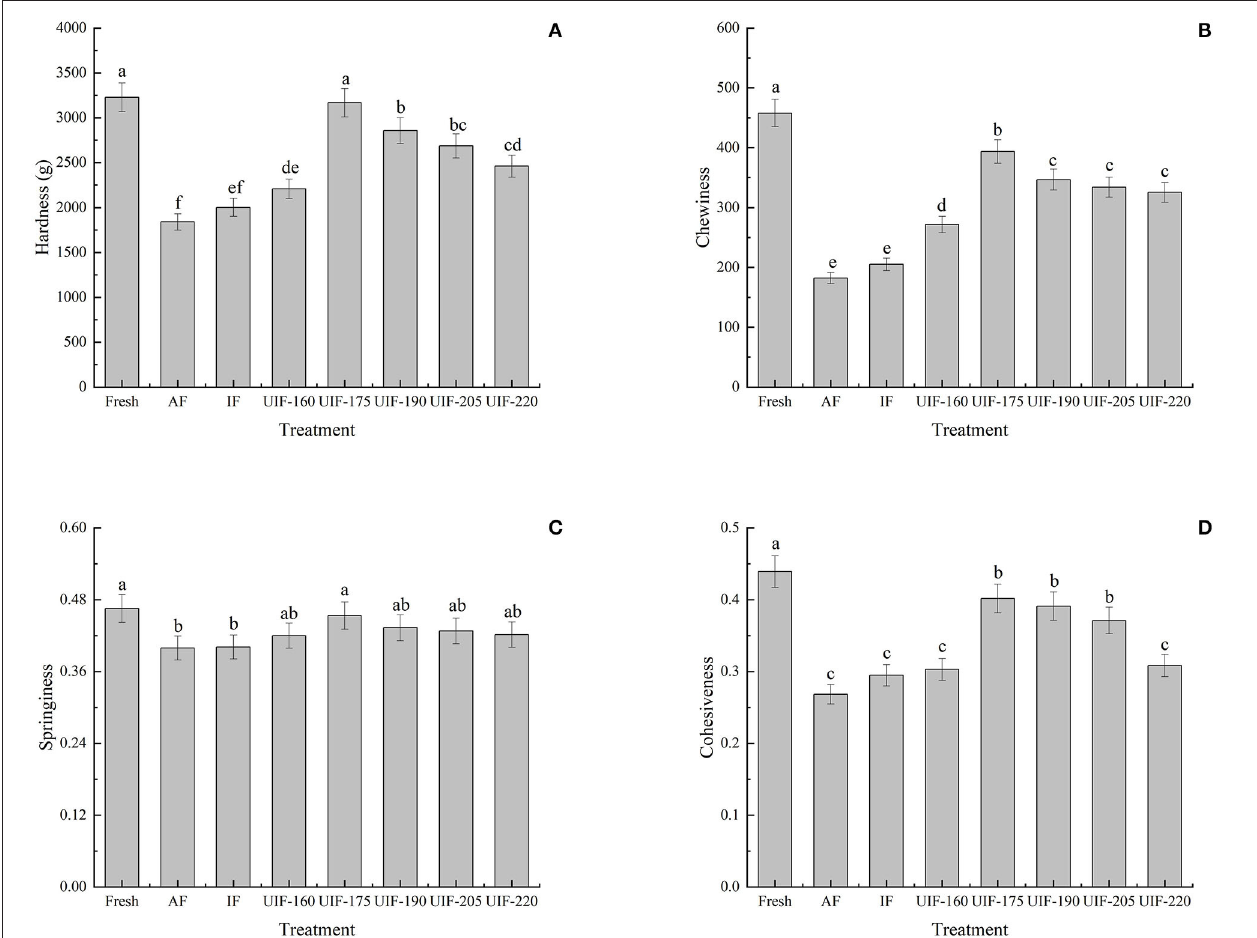
FIGURE 5 | Influence of different freezing treatments on the hardness (A) , chewiness (B) , springiness (C) , and cohesiveness (D) of the large yellow croaker. The results are average ± standard deviation ( n = 3).